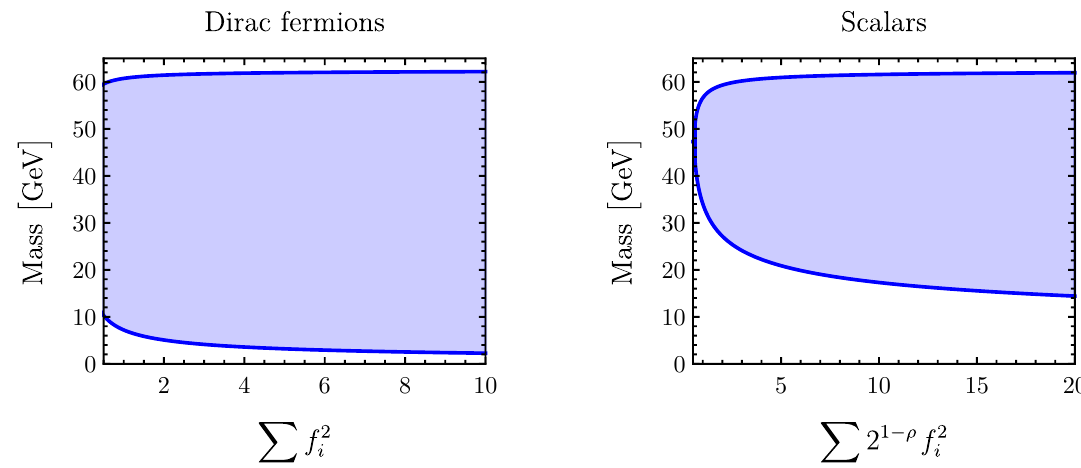
(cid:0) P 2 1 − ρ (cid:1) plane for new Dirac fermion f 2 i i